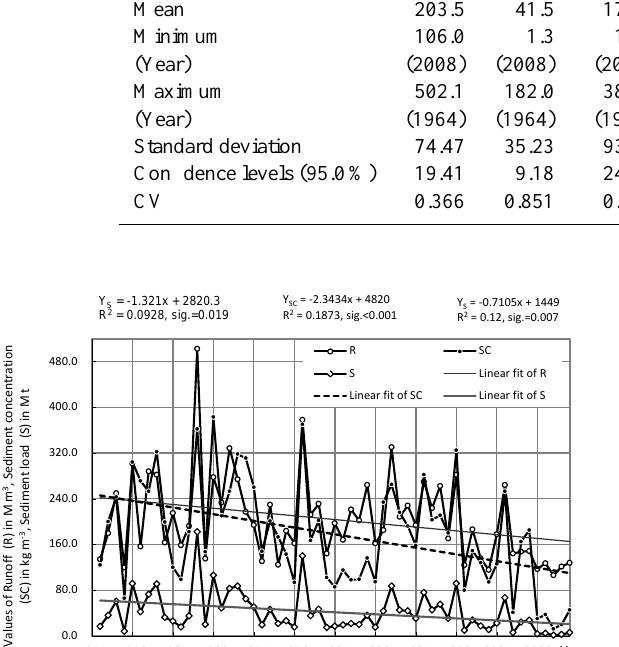
Fig. 2. Annual runoff, sediment concentration and sediment load change in 1952–2010. 4